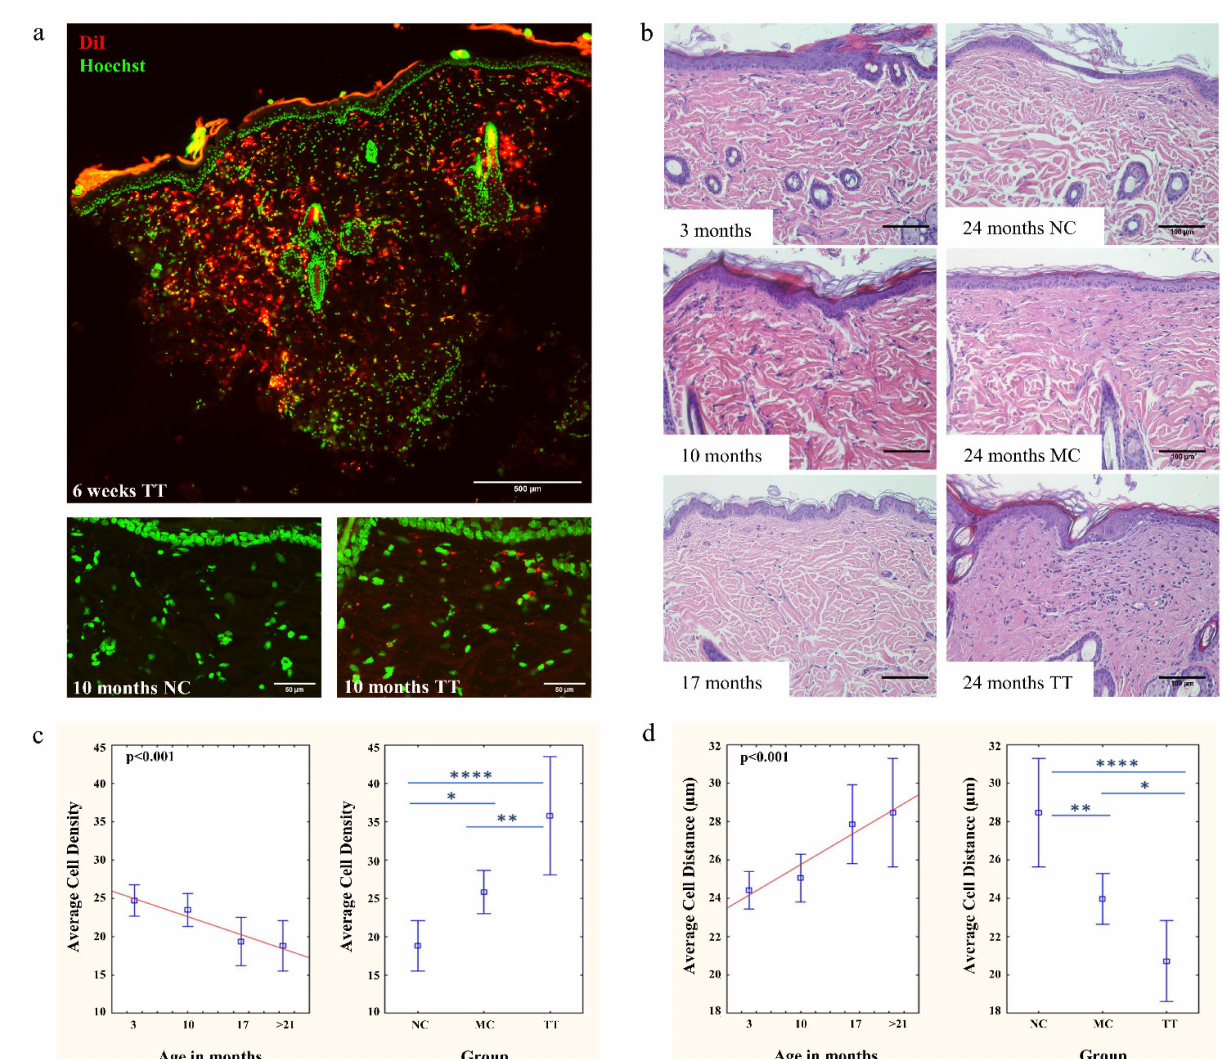
Figure 1. Young fibroblasts are efficiently implanted into aged rat skin. ( a ) Successful implantation of fibroblasts (red) in skin of 12-month-old animal 6 weeks following treatment (6 weeks TT); cell nuclei depicted in green. Scale bar is 500 µ m. Ten months following treatment, cells are stably implanted and viable (10 months TT and NC); scale bar is 50 µ m. ( b ) Aging dynamics in skin were followed by hematoxylin/eosin staining in 3, 10, and 17-month-old rat skin. H&E of 24-month-old rat skin shows non-treated (NC), mechanically treated (MC), and tissue treated with young cells (TT) from same animal; scale bar is 100 µ m. Left graphs represent ( c ) average cell density and ( d ) average cell distance in untreated skin. Right graphs represent changes in cell density or distance in old animals following micro-transplantation procedure. n = 3 per group; error bars represent mean ± 0.95 confidence intervals; * p < 0.05; ** p < 0.01; **** p <